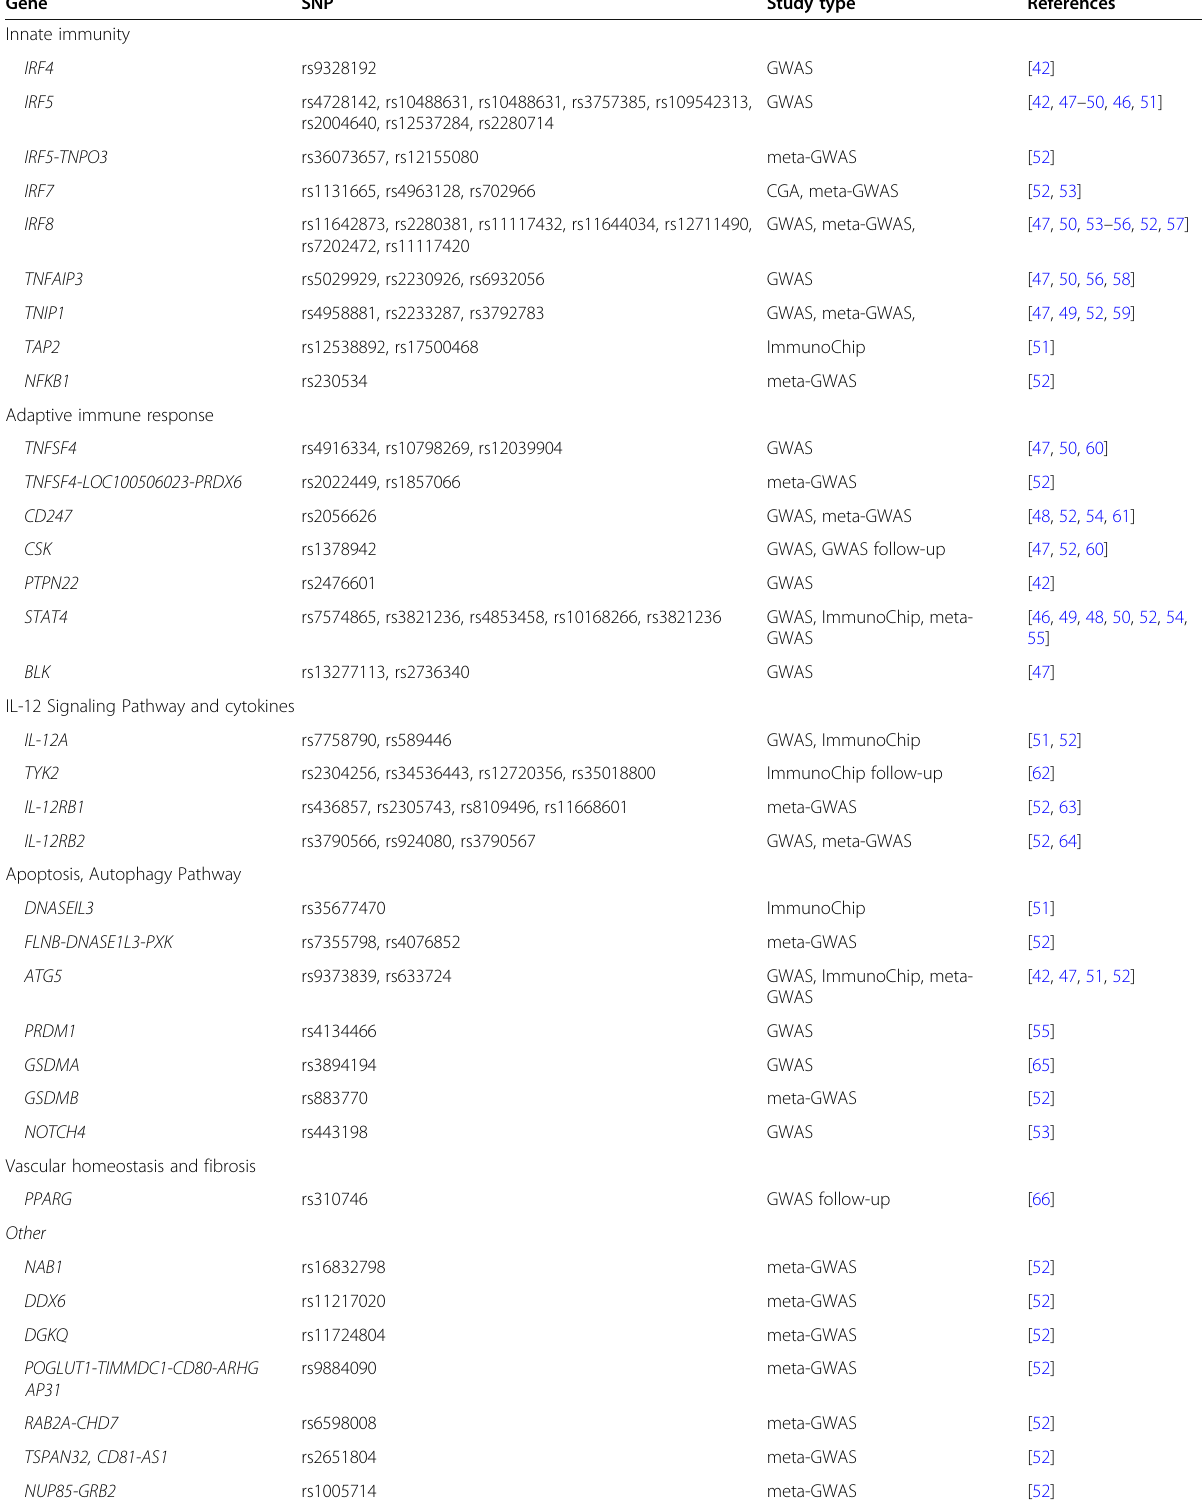
Table 2 Non-HLA SSc susceptibility genes identified by the GWAS